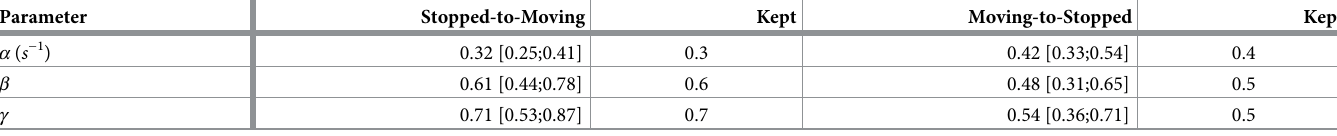
Mean estimates and 95% CI are given for each parameter and for both kinds of transition. In Kept columns are reported the mean estimates rounded at the first decimal, which was retained in numerical